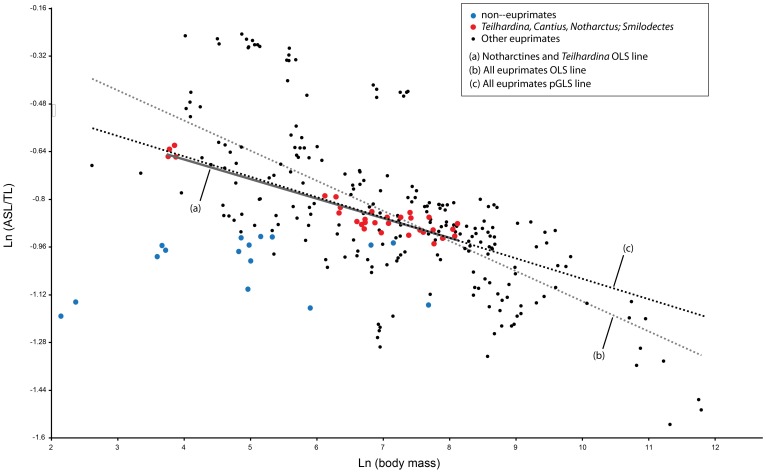
Comparison of ordinary least squares (OLS) and phylogenetic generalized least squares lines fit to an “all primate” sample.Adding data from all extant primate groups leads to a much steeper ordinary least squares regression slope (b) than given by analyzing smaller samples of closely related taxa (e.g., a). However, PGLS style regression using the caper package of R shows that phylogenetic autocorrelation of values has little affect for small samples of closely related taxa (low values of λ in Table 5) meaning that OLS and PGLS give nearly identical results. However, phylogenetic autocorrelation has a strong effect in larger samples (higher λ values in Table 5). The maximum likelihood PGLS regression equations for large samples (c) thus show a much different slope than the OLS equations for these samples. The PGLS slope and intercept are instead much closer to that for small samples.